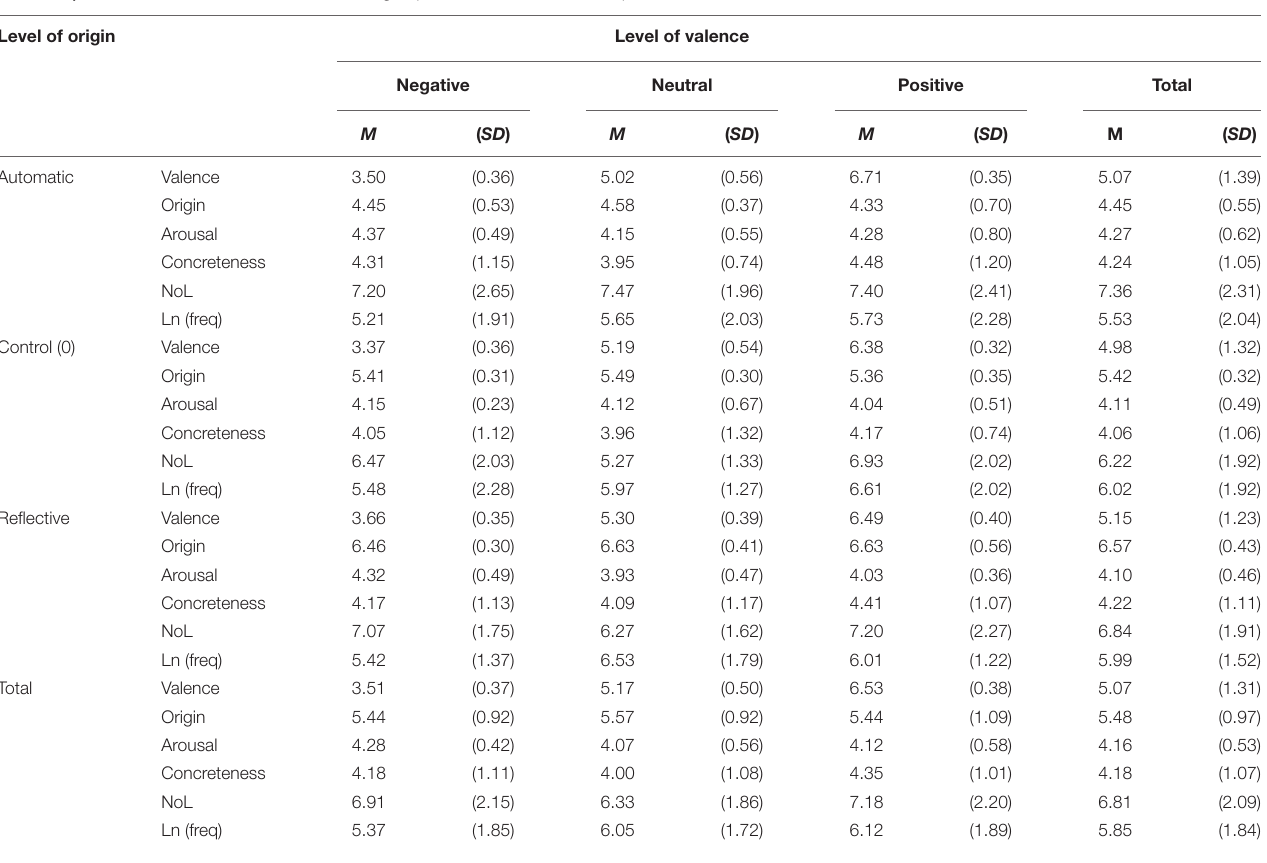
TABLE 1 | Means and standard deviations for nine groups of words used as the dependent